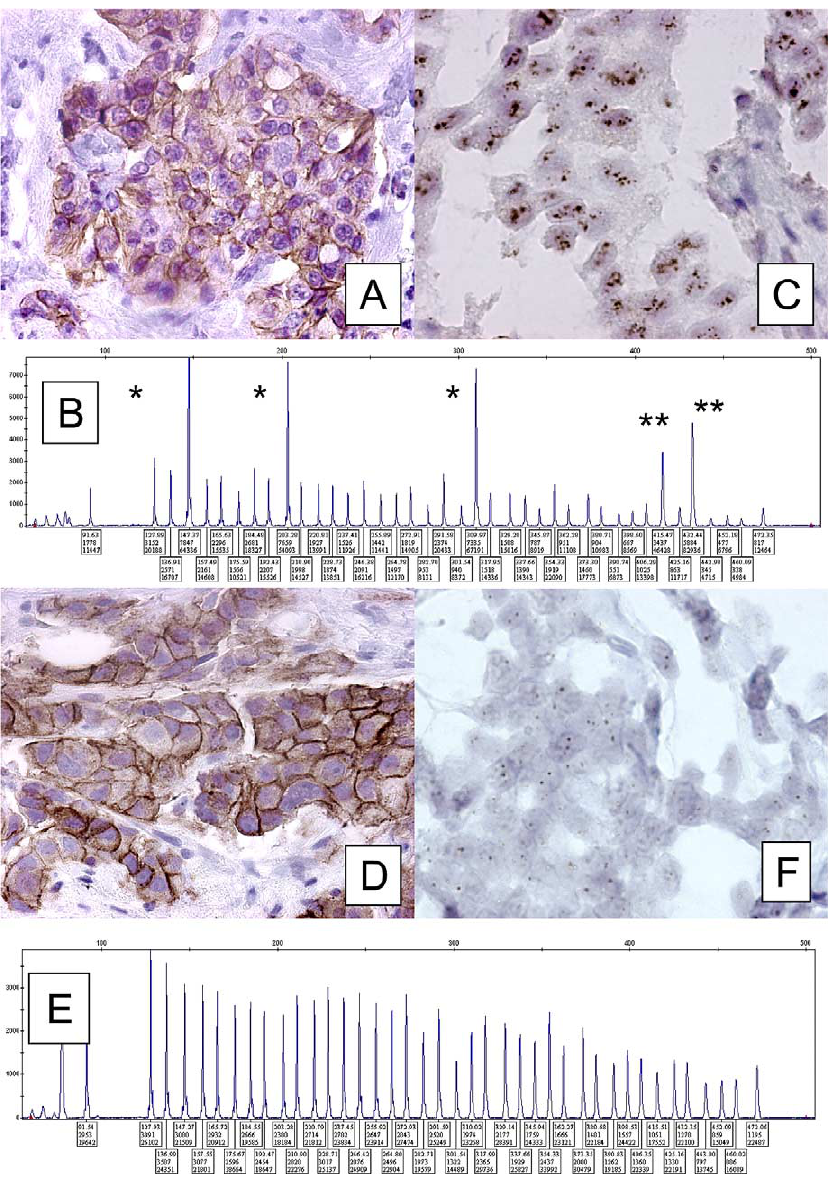
Fig. 1. MLPA, CISH and IHC to detect HER-2 amplification in invasive breast cancer. (A) HER-2 IHC 1 + case with in (B) amplification by MLPA (see 3 HER-2 probe peaks (*) way above the controls and two other chromosome 17 peaks (**) co-amplified) as confirmed by CISH in (C). (D) HER-2 IHC 3 + case with in (E) no amplification by MLPA (none of the 3 HER-2 probe peaks above the controls) or CISH in